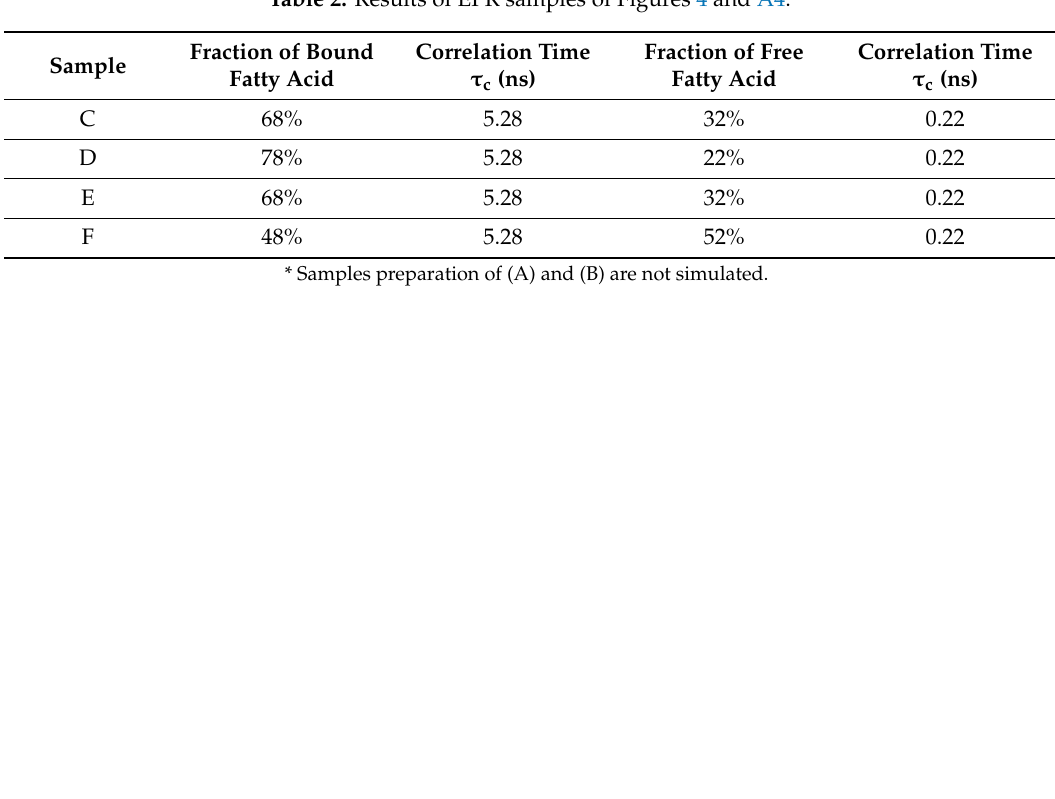
Table 2. Results of EPR samples of Figures 4 and